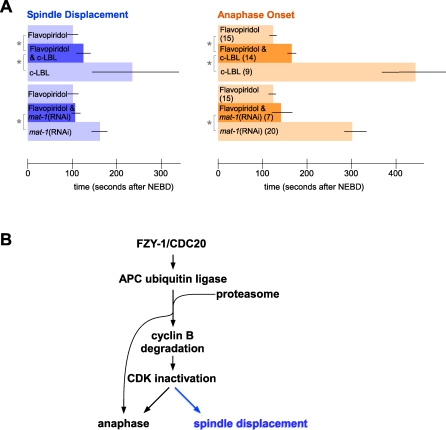
The Proteasome and APC Function in Spindle Displacement Primarily Through CDK Inactivation(A) Flavopiridol treatment rescued most of the delay of anaphase onset and spindle displacement induced by the proteasome inhibitor c-LβL. Flavopiridol treatment completely rescued the delays induced by mat-1 RNAi, for both anaphase onset and spindle displacement. Error bars represent the 95% confidence interval for significance, and asterisks represent statistical significance at p < 0.05. Number of cases analyzed for each experiment is indicated in parentheses on the anaphase onset bars. For statistical values, see Methods.(B) A working model for regulation of spindle displacement (blue) by the Cdc20/Fizzy, APC, cyclin-CDK pathway (black). We predict that a known or unknown molecule that functions in spindle displacement may be a direct or indirect target of CDK activity.